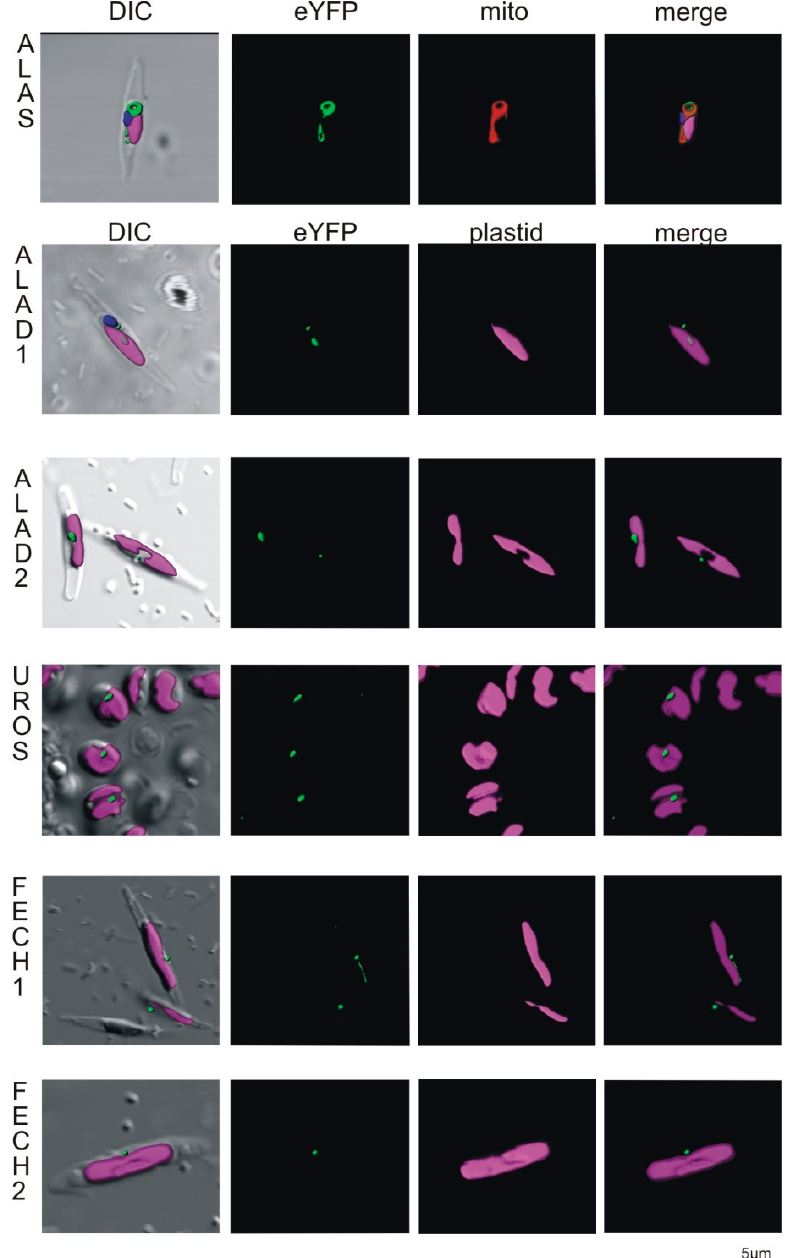
Figure 5. Heterologous expression of Phaeodactylum tricornutum with genes from Chromera velia heme pathway enzymes. Selected enzymes were tagged on their C-terminus by eYFP (green), magenta indicates plastid autofluorescence, MitoTracker ® Orange CM-H2TMRos (ALAS, red) indicates mitochondrion. Green eYFP signal of C. velia ALA synthase colocalizes with red signal of P. tricornutum mitochondrion (row ALAS). Typical “blob-like” structures are found in heterologous expression of ALA dehydratases (ALAD1, ALAD2), uroporphyrinogen synthase (UROS) and both ferrochelatases (FECH1, FECH2).